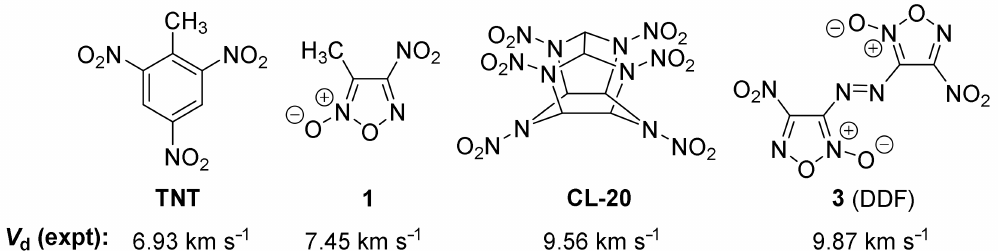
Figure 1. Two promising furoxan-based energetic compounds considered in the present work ( 1 and 3 ) in comparison with the reference high explosives trinitrotoluene (TNT) and CL-20 along with their experimental velocities of detonation ( V d )